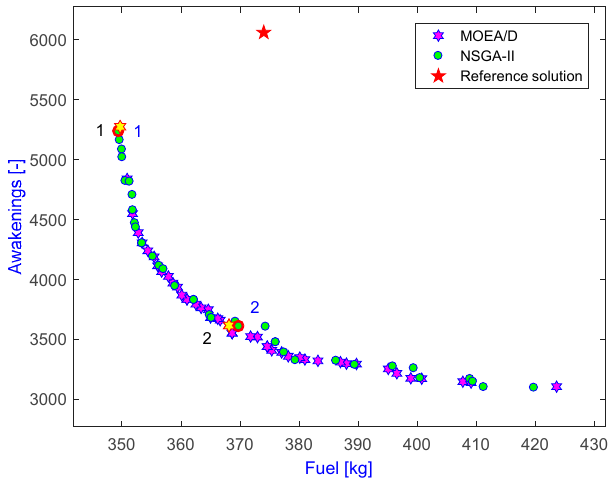
Figure 7. Comparison of optimal solutions obtained by NSGA-II and MOEA/D and the reference case.